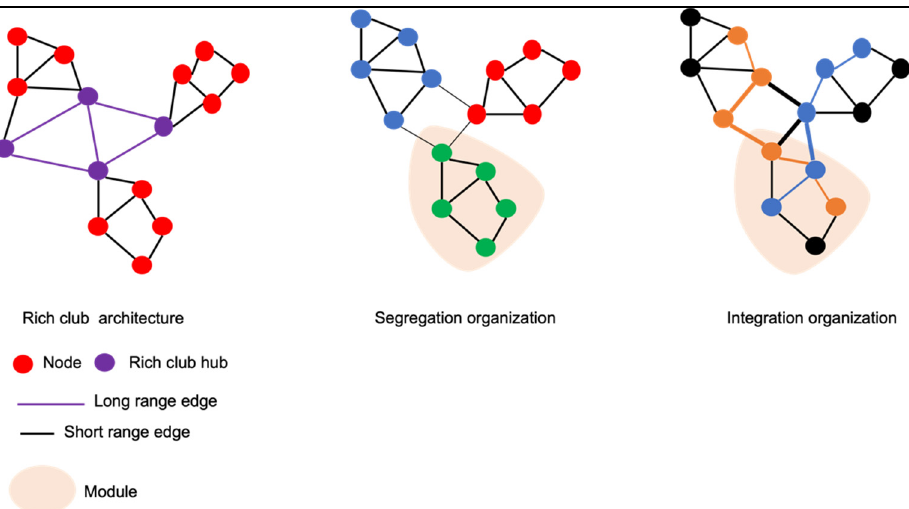
Figure 3. Illustration of a cerebral network according to the graph theory: nodes are connected one over another by edges. Nodes which play a significant role in exchanging information are hubs. Well-interconnected hubs belong to a rich club. In a segregation organization, modules represent networks with dense connections between nodes within the same module but sparse connections between nodes of other modules. In an integration organization, disparate brain modules are well-interconnected.